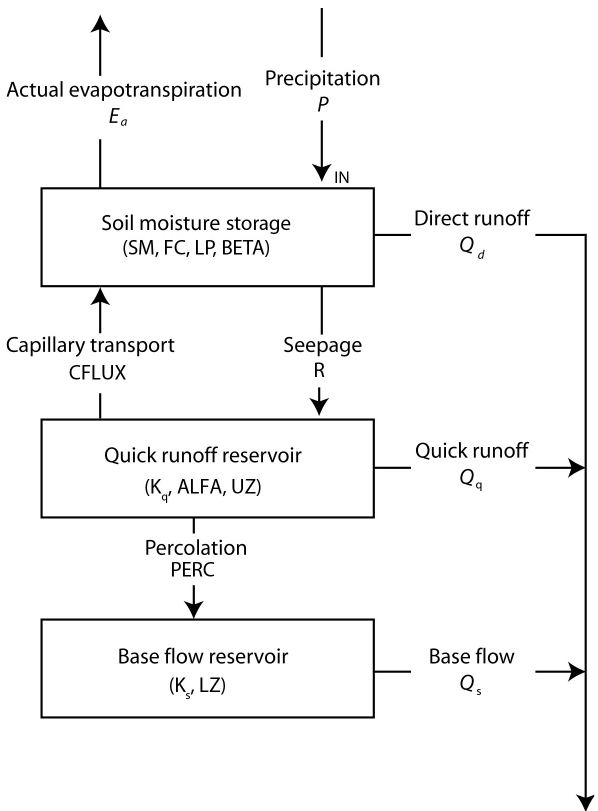
Fig. 2. A diagram of the HBV-96 approach (modified after Lind- str¨om,